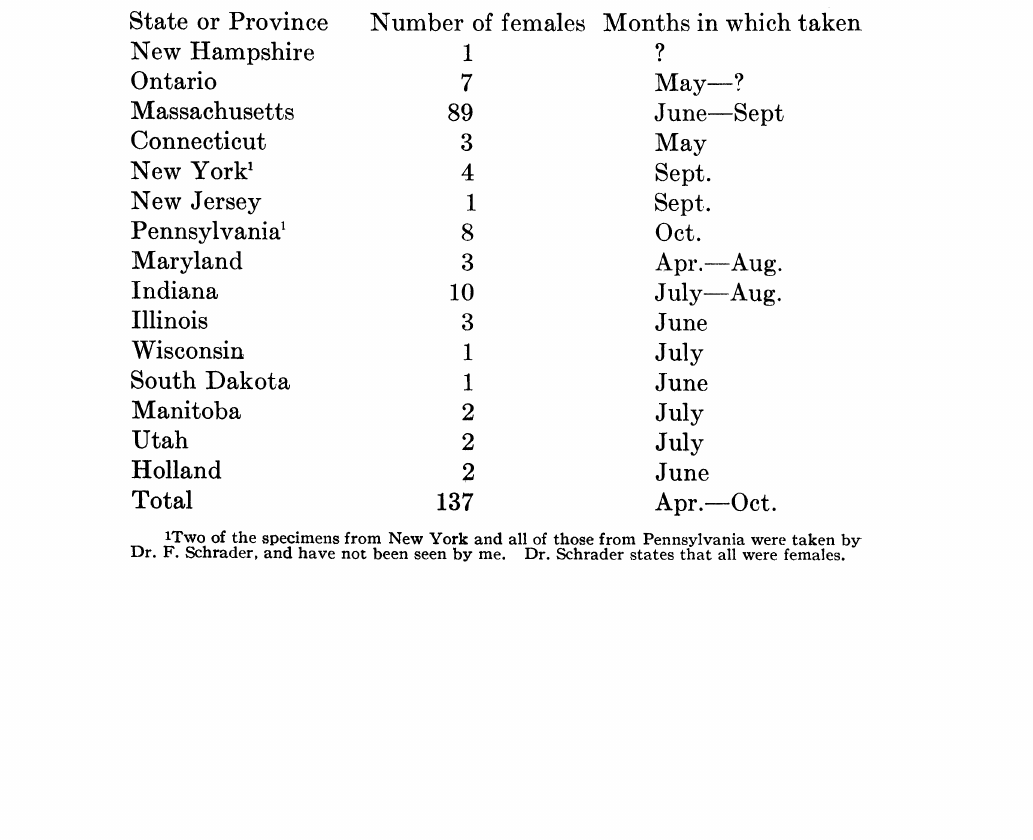
Distribution of Ochthiphila polystigma